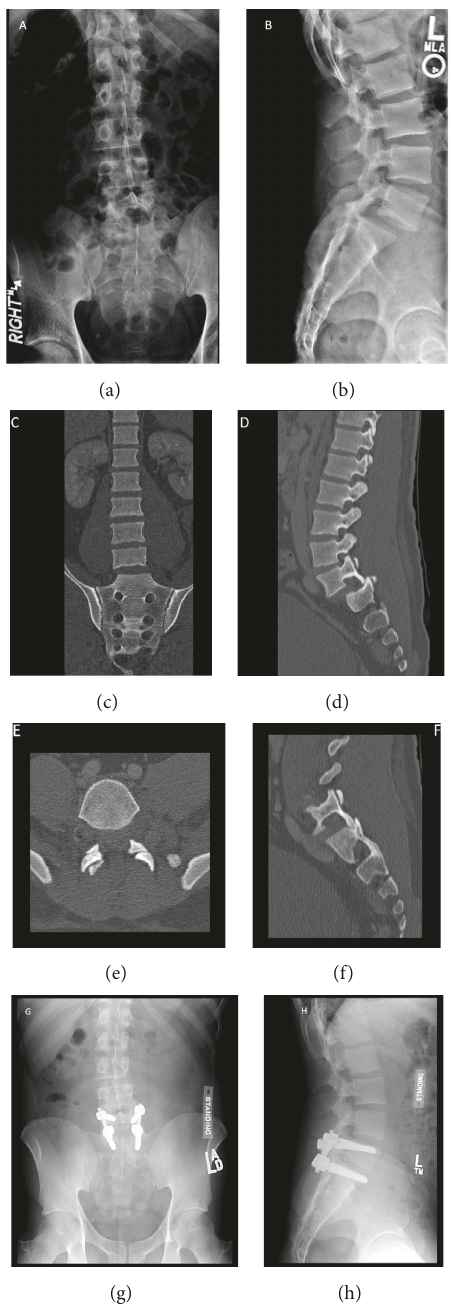
Figure 2: Imaging of a 25-year-old male patient who was involved in an all-terrain vehicle accident. He was ejected from the vehicle and presented with low back pain and intermittent bilateral lower extremity radicular pain with paresthesia. Figures (a) and (b) demonstrate anteroposterior and lateral radiographs, respectively. Coronal CT shows minimal lateralization of L5 over S1 (c). Sagittal view shows anterior dislocation of L5 over S1 with jumped facets (d). Axial (e) image cut through the same level as the sagittal image (f) shows bilateral jumped facets at L5-S1. The patient underwent pos- terior spinal instrumentation and fusion of the L5 and S1 vertebrae using pedicle screws and rods. Postoperative anteroposterior (g) and lateral (h) images demonstrate a reduced L5-S1 joint. (Courtesy